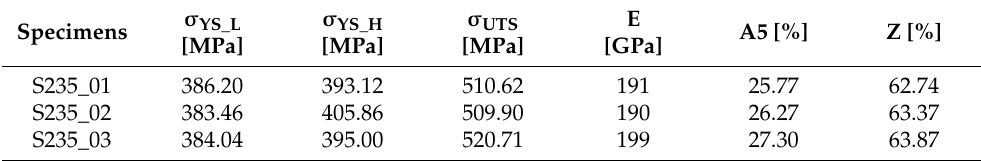
Table 1. Mechanical characteristic of S235 steel.